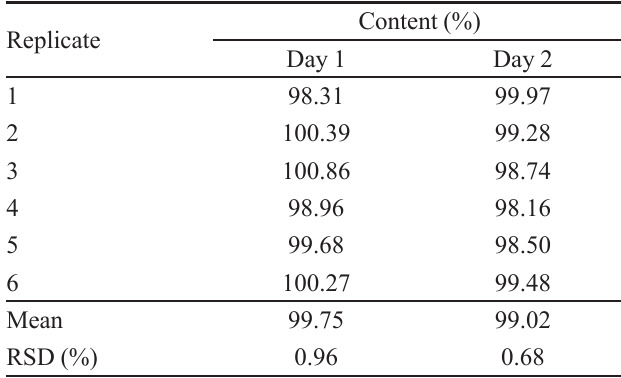
TABLE IV - Data from repeatability and intermediate precision Replicate